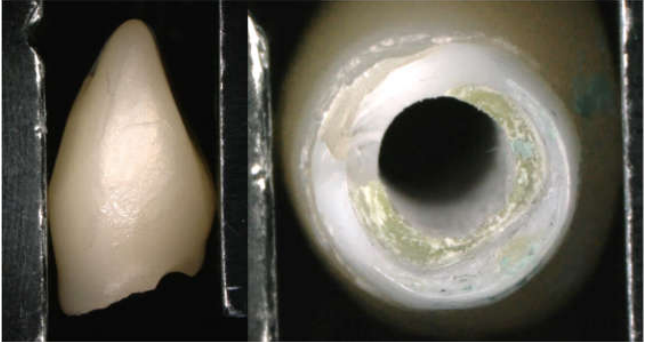
Figure 8. Fracture mode in AM-Zr group (horizontal fracture pattern similar to ASC-Zr group, but the fracture surface is even higher). Table 2. Mean fracture resistance of zirconia abutments.